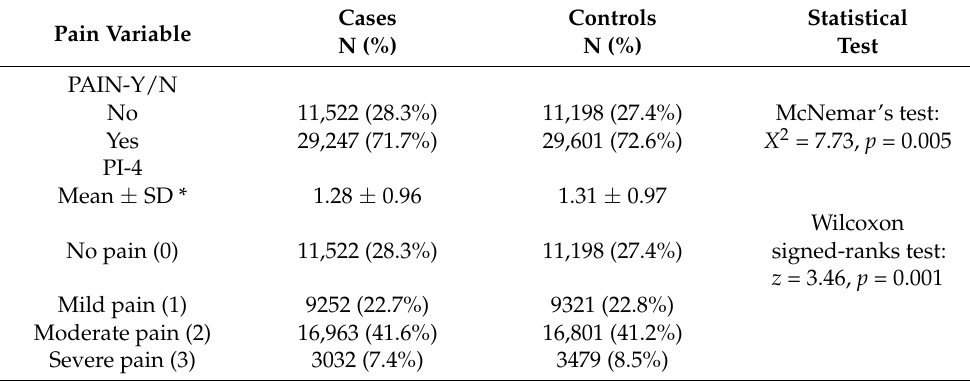
Table 2. Comparison for dichotomous pain (PAIN-Y/N) and four-point pain scale (PI-4) between cases (hypertension) and controls (no hypertension), n = 40,799 in each group.